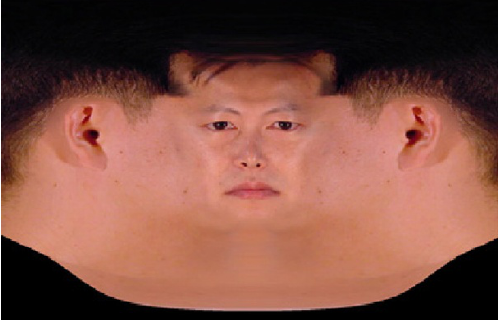
Figure 19: Generated combined texture on the public UV plane.